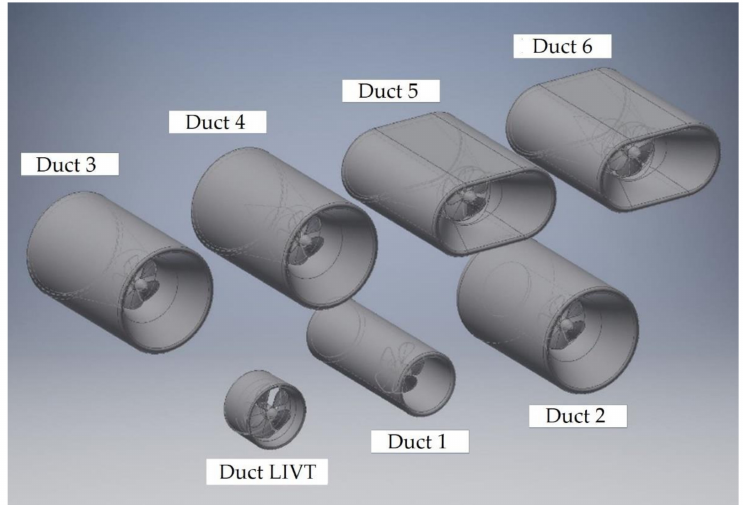
Figure 2. 3D duct